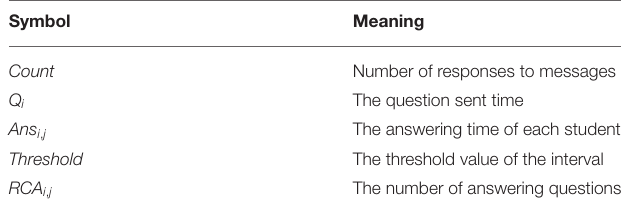
FIGURE 2 | System model.